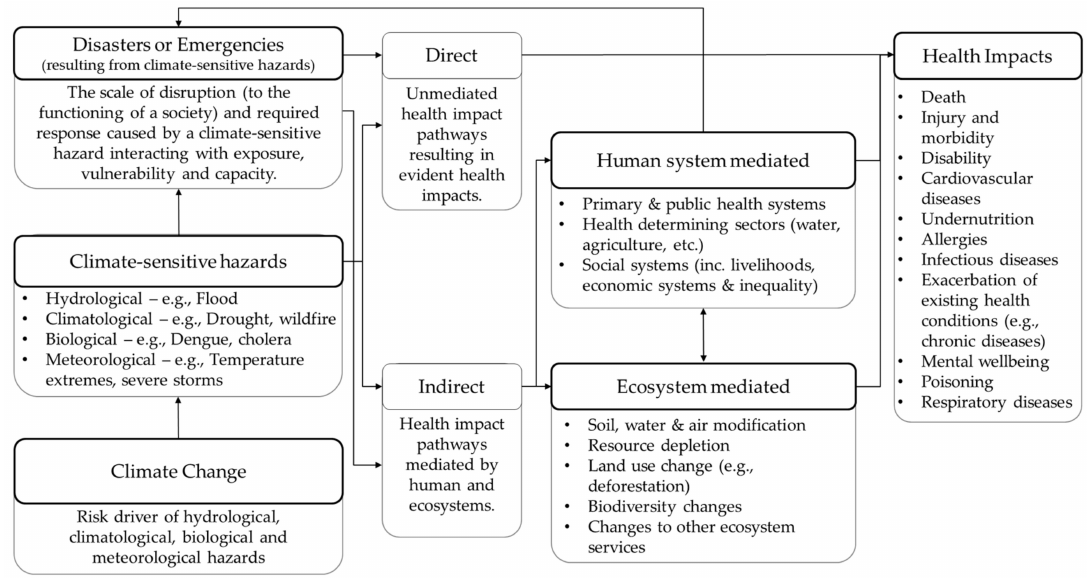
Figure 1. Direct and indirect health impact pathways of climate change and climate-sensitive disasters. Developed based on frameworks contained in